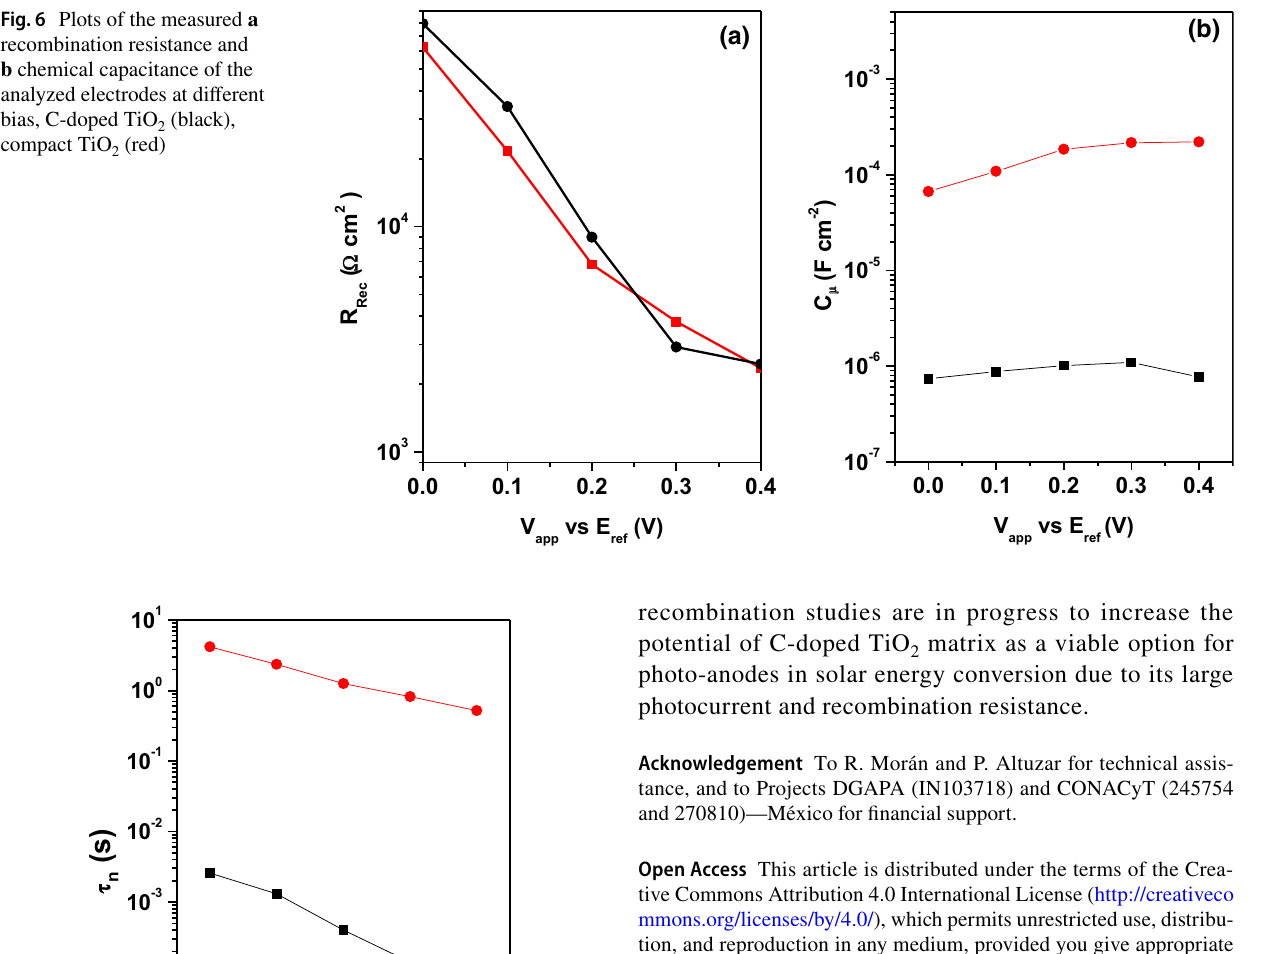
Fig. 6 Plots of the measured a